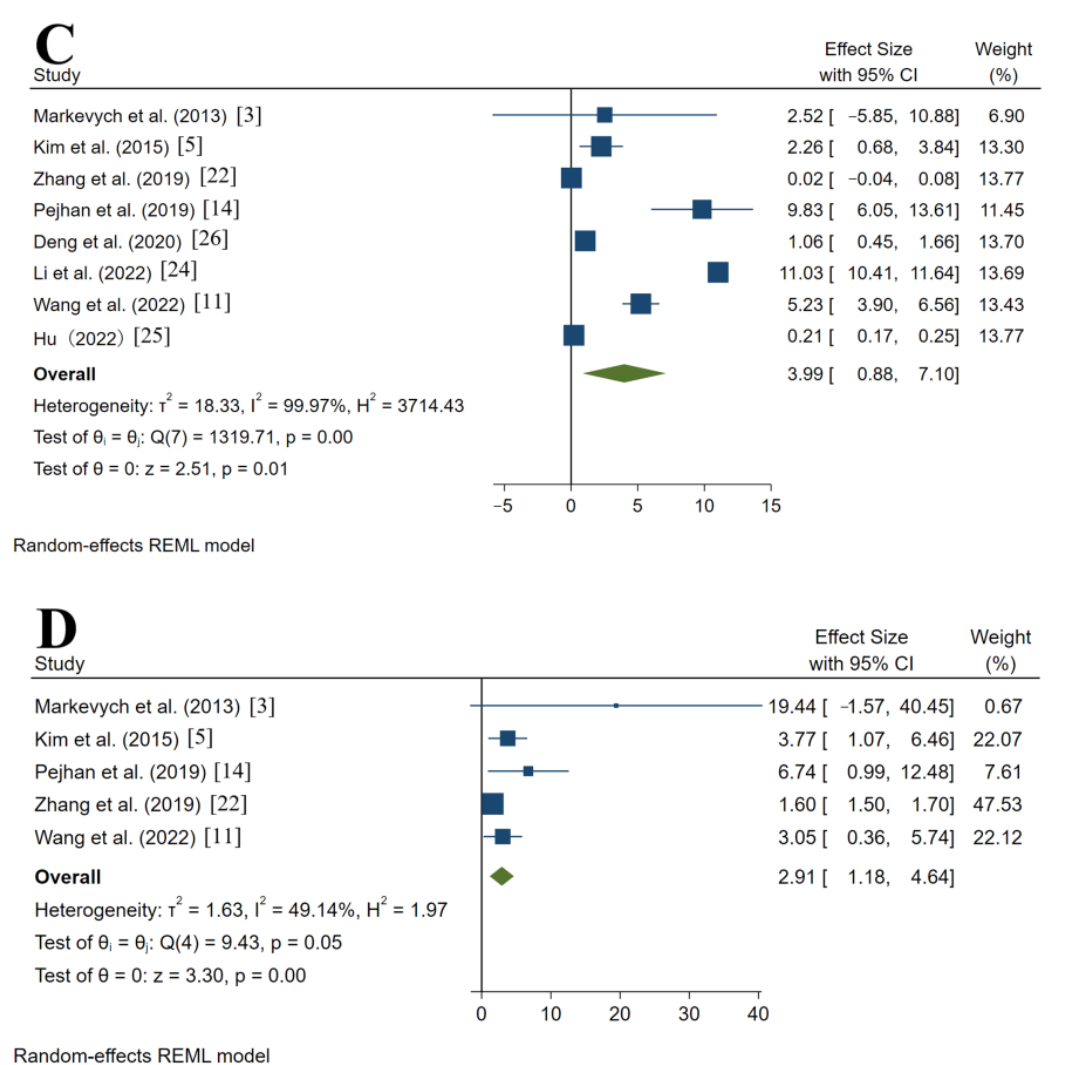
Figure 2. Association of PM2.5 exposure with levels of ALP ( A ), ALT ( B ), AST ( C ), and GGT ( D ) according to a random-effects meta-analysis. CI, confidence interval (95% CI are for a 10 µ g/m 3 increase in PM2.5); ALP, alkaline phosphatase; ALT, alanine aminotransferase; AST, aspartate transferase; GGT, gamma-glutamyl transferase.